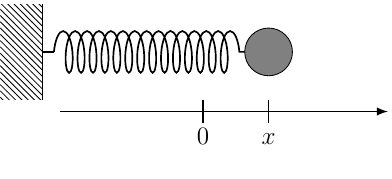
Fig. 102.— Harmonic oscillator: particle on a